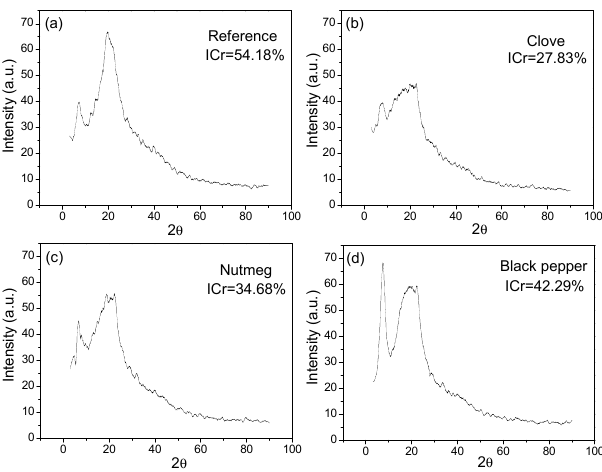
Figure 9. Diffractogram biocomposite films ( a ) Reference (without oleoresin); ( b ) with clove oleoresin; ( c ) with nutmeg oleoresin; ( d ) with black pepper oleoresin.